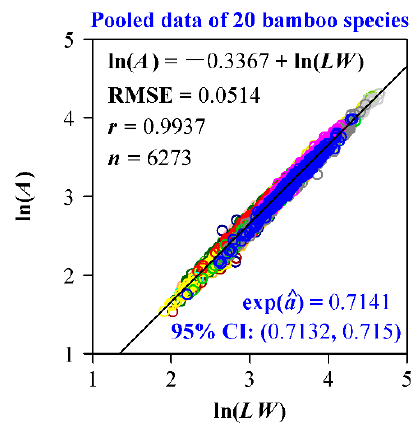
Figure 4. Linear regression of the Montgomery equation for the pooled data of 20 bamboo species. A denotes leaf area; L represents leaf length; W represents leaf width; RMSE represents the root-mean-square error; r represents the correlation coefficient; n represents the number of leaves sampled; exp(ˆ a ) represents the estimate of the Montgomery parameter; 95% CI denotes the 95% confidence interval of the estimate of the Montgomery parameter. Open circles (among which different colors represent different bamboo species) represent the observations, and the solid straight line represents the fitted regression line.